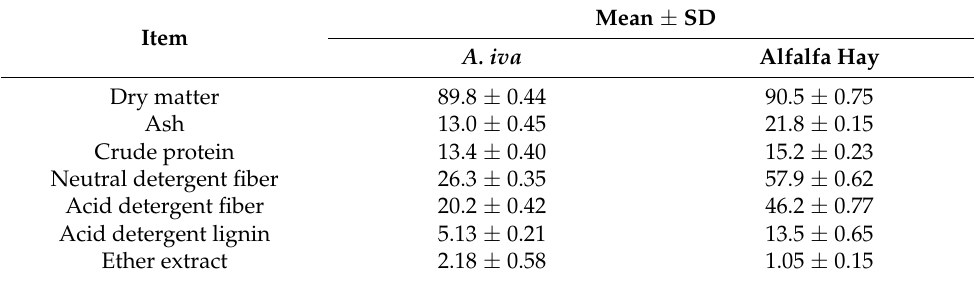
Table 1. Chemical composition (% DM) of leaves of A. iva and alfalfa hay collected from rangelands of Mograne ( n = 3 samples, 3 replicates per sample).